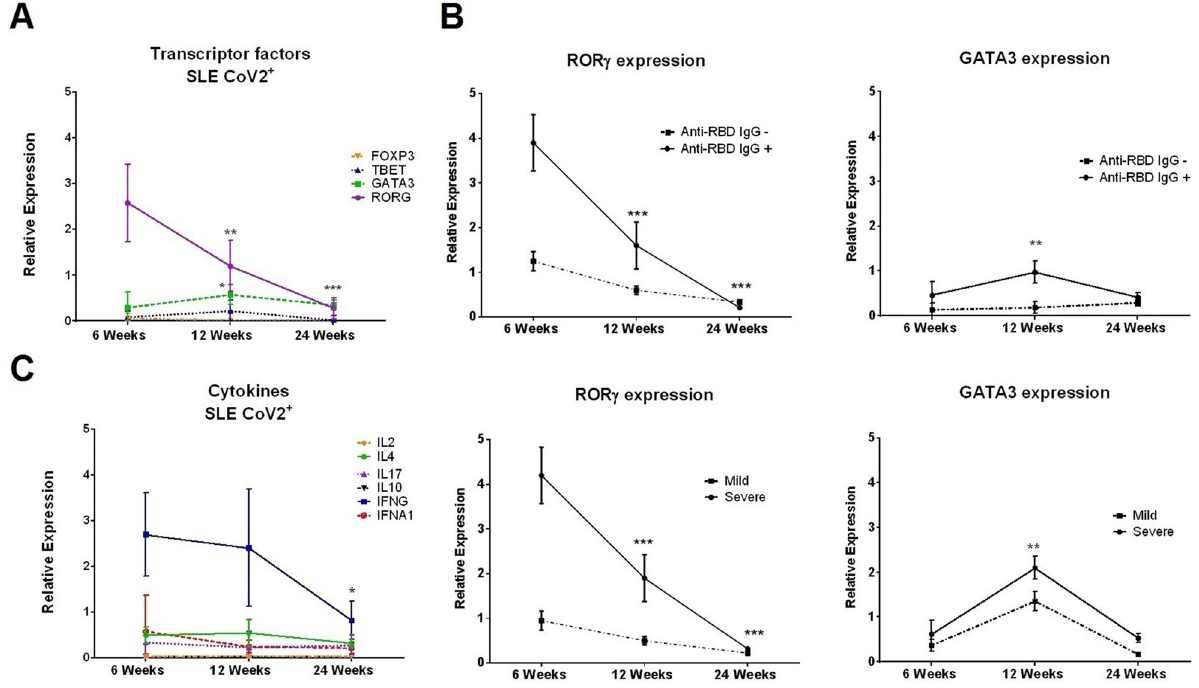
Figure 5. A decrease of Th17 signaling was observed in immune longitudinal analysis in exposed SARS- CoV-2 lupus patients. ( A ) Gene expression of transcription factors at 6-, 12- and 24-weeks post symptom onset (N = 12). The vertical axis shows the relative expression, and the horizontal axis shows time. Error bars represent the mean ± SEM from 12 lupus patients. Significant differences were calculated in comparison with the 6-week timepoint using paired t-test. * p < 0.05, *** p < 0.0001. ( B ) Gene expression of transcription factors for Th17 (RORG) and Th2 (GATA3) were evaluated longitudinally in convalescent SARS-CoV-2 lupus patients according to the production of antibodies against RBD protein (anti-RBD IgG + or IgG − ) and disease severity (mild or severe). Fold change significant differences over time were calculated between groups by linear mixed models * p < 0.005, *** p < 0.001. ( C ) Cytokines were evaluated longitudinally in convalescent lupus patients by RT-qPCR gene expression analysis. Significant differences were calculated in comparison to the 6-week timepoint. Only interferon gamma (INFG) was significantly decreased at 24 weeks using paired t-test. * p < SARS-CoV-2 IgG antibody prevalence was 8.33%. Our findings differ from the 16% reported by Saxena A et al. 45 . Cohorts were similar except by the higher rates of Hispanic ethnicity in their study having a higher anti- body production. Reported seroconversion rates after SARS-CoV-2 symptomatic infection range from 91 to 99% in the general population 58 . SARS-CoV-2 IgG antibodies are generally detected 2 weeks after infection and have a variable durability. As previously reported, most lupus patients (75%) with RT-PCR-confirmed SARS-CoV-2 infection developed SARS-CoV-2 IgG antibodies despite 69% being on immunosuppressants, and titers were cor- related with disease severity 59–61 . Lack of antibody response was associated with prednisone doses ≥ 7.5 mg/day.